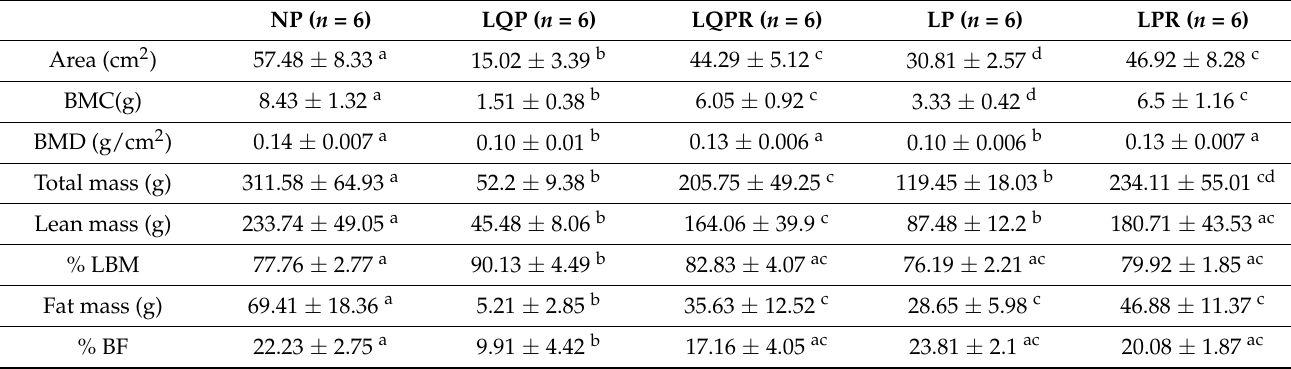
Table 4. Effect of maternal quality and quantity protein restriction followed by rehabilitation on whole-body composition and metabolic factors in the offspring at 10 weeks after